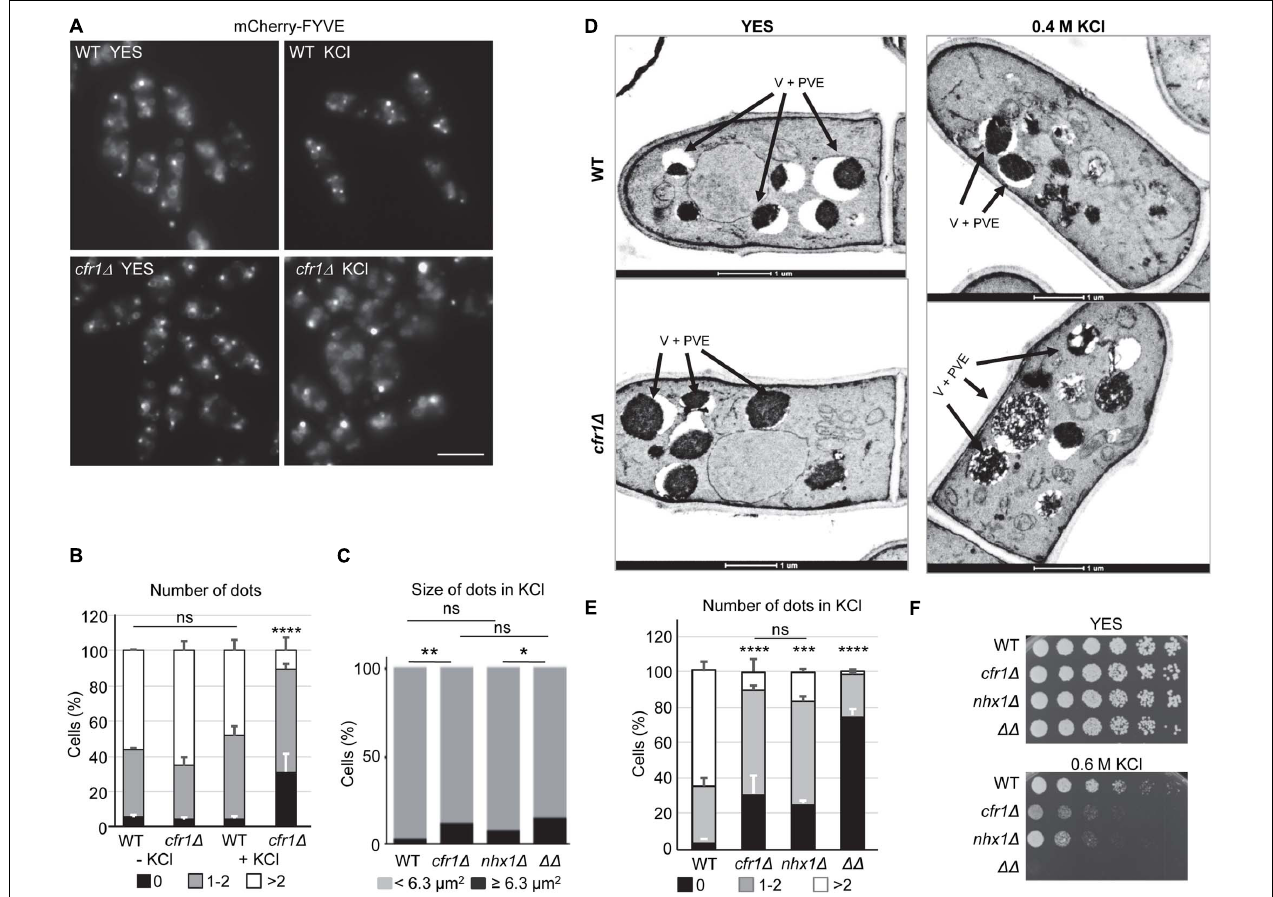
FIGURE 6 | Analysis of the prevacuolar endosome in exomer mutants. (A) Wild-type (WT) and cfr1 (cid:49) cells with the PVE marker mCherry-FYVE incubated in YES and YES with 0.6 M KCl. Images are single planes captured with a Nikon Eclipse 90i. Bar, 10 µ m. (B) The same experimental details as in (A) . The percentage of cells without mCherry-FYVE dots, 1-2 dots, and more than two dots were scored from the photographs. (C) The same experimental details as in (A) . The percentage of WT, cfr1 (cid:49) , nhx1 (cid:49) , and cfr1 (cid:49) nhx1 (cid:49) ( (cid:49)(cid:49) ) cells with mCherry-FYVE dots of the indicated size were scored. (D) Transmission electron microscopy of WT and cfr1 (cid:49) cells incubated with 0.4 M KCl for 1 h. Arrows denote vacuoles and prevacuolar endosomes (V + PVE). (E) The same experimental details as in (A) . The percentage of cells from the indicated strains without mCherry-FYVE dots, 1–2 dots, and more than two dots were scored. (F) Cells from the WT, cfr1 (cid:49) , nhx1 (cid:49) , and cfr1 (cid:49) nhx1 (cid:49) ( (cid:49)(cid:49) ) strains were spotted on YES and YES with 0.6 M KCl. In (B,C,E) , the media, standard deviation, and statistical significance of the differences from three independent experiments—determined using Tukey’s multiple comparisons test—are shown for each value (ns, non-significant; * p < 0.05; ** p < 0.01; *** p < 0.001; **** p <